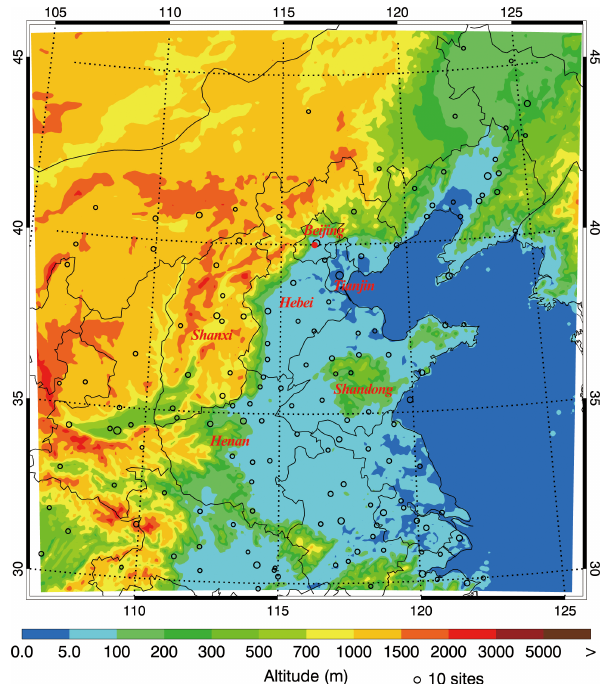
Figure 1. WRF-Chem simulation domain with topography. The cir- cles represent centers of cities with ambient monitoring sites, and the size of circles denotes the number of ambient monitoring sites of cities. The red circle denotes the observation site for aerosol species at the National Center for Nanoscience and Technology (NCNST), Chinese Academy of Sciences,